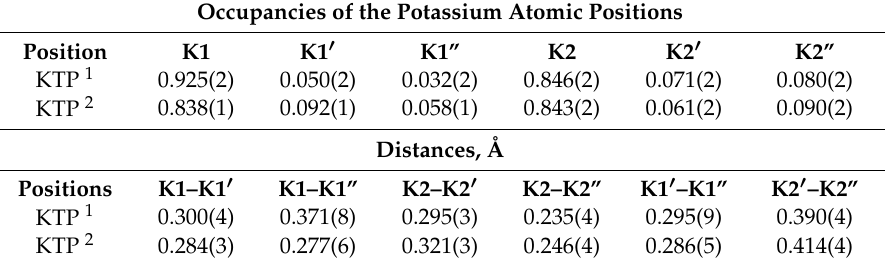
Table 1. Occupancies of potassium atomic positions and distances between these positions in the structures of KTP single